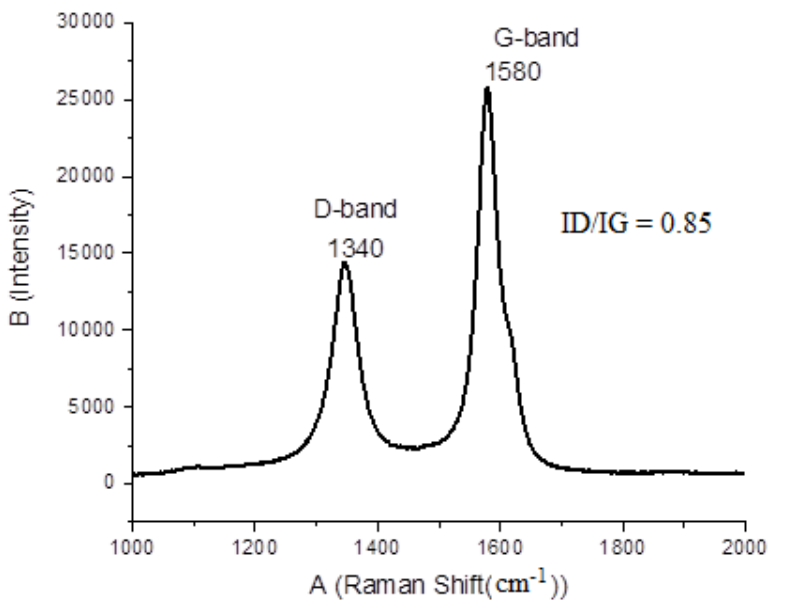
Figure 11. Raman spectra of CNTs synthesized at 825 °C with 12 min combustion time over a Ni4Mo0.2MgO1 catalyst.